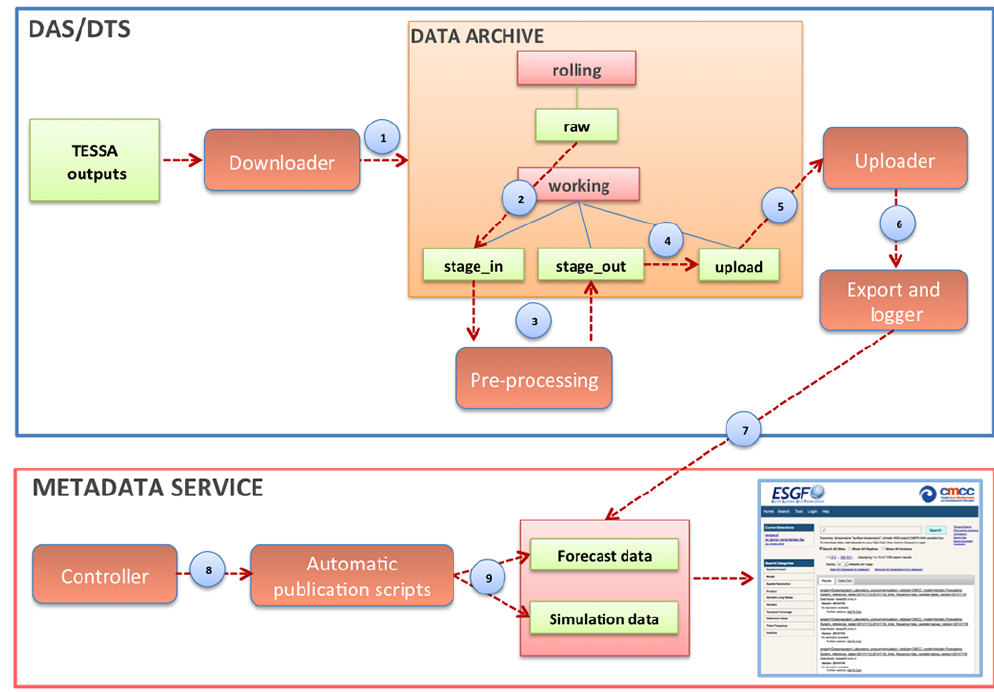
Figure 7. Operational chain for ESGF data